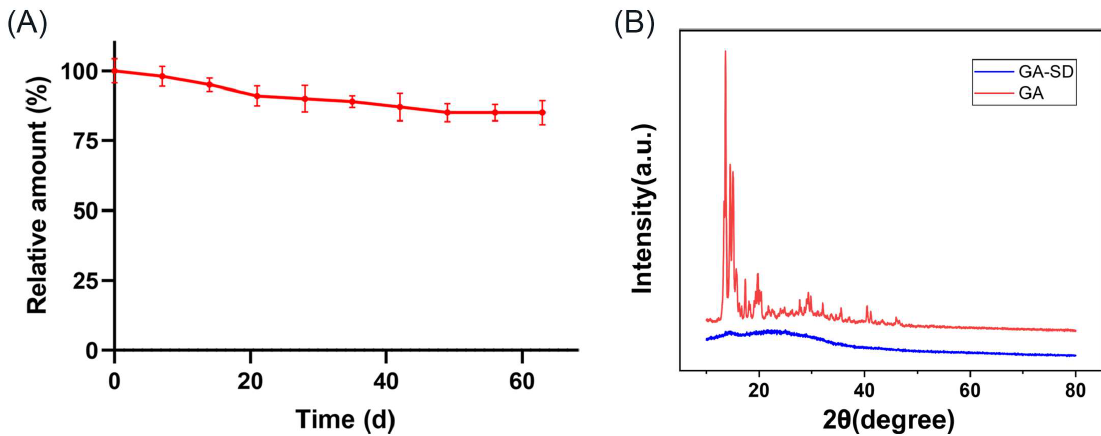
Figure 5. Stability of GA-SD. ( A ) Experimental results of GA-SD placement stability. Values are presented as the mean ± SD ( n = 3). ( B ) Changes in the crystalline content of GA-SD after storage at 4 °C for 7 months.